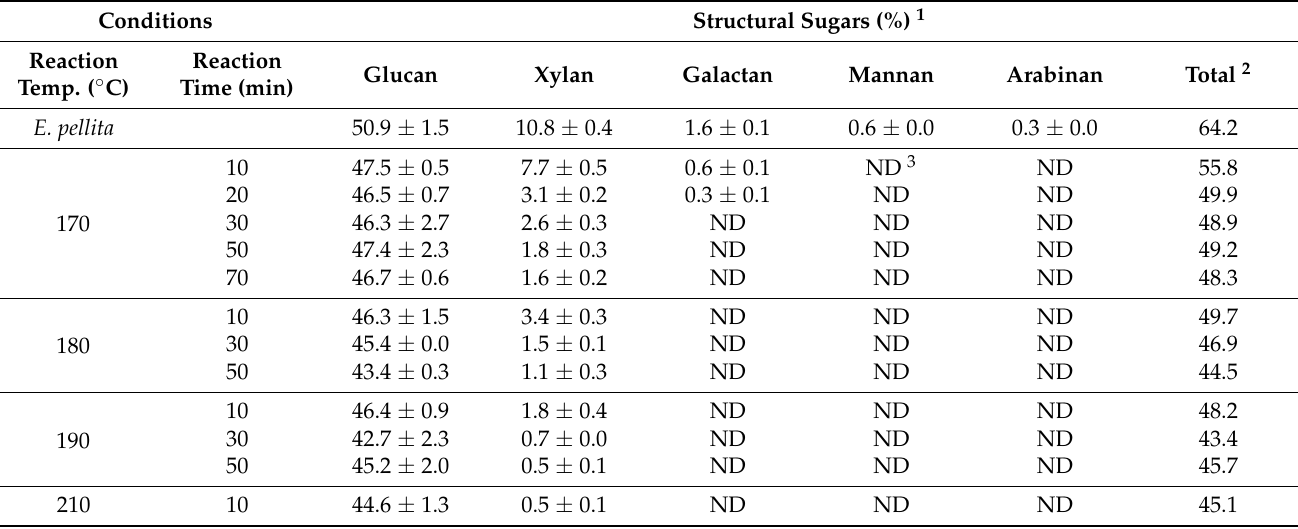
Table 2. Structural sugar contents of E. pellita and the solid fractions obtained by LHW treatment. Conditions